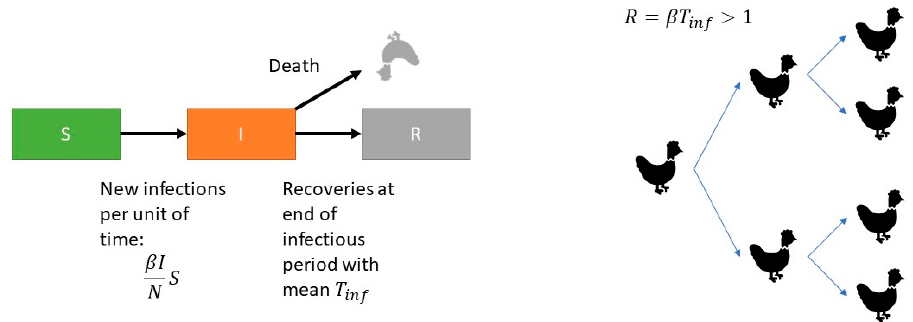
Figure 1. Diagram of the transmission model. Infection occurs with a rate proportional to the fraction of infectious birds β I and birds recover or die at the end of infectious period with mean T inf . Multiplication of the transmission coefficient and the mean infectious period T inf . is the basic reproduction number R . For R > 1 an exponential growing infection will occur in a susceptible population and for R < 1 the infection will go extinct.